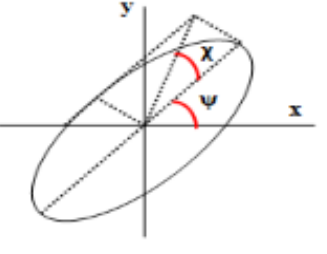
Figure 3. Definition of polarization signature